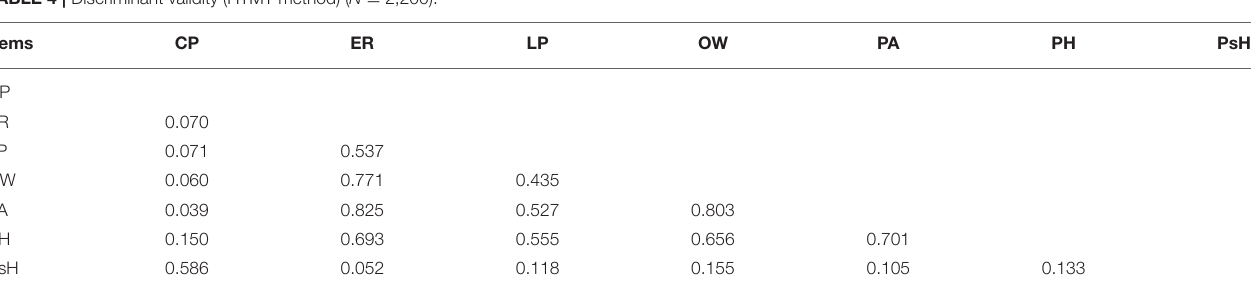
TABLE 4 | Discriminant validity (HTMT method) ( N =